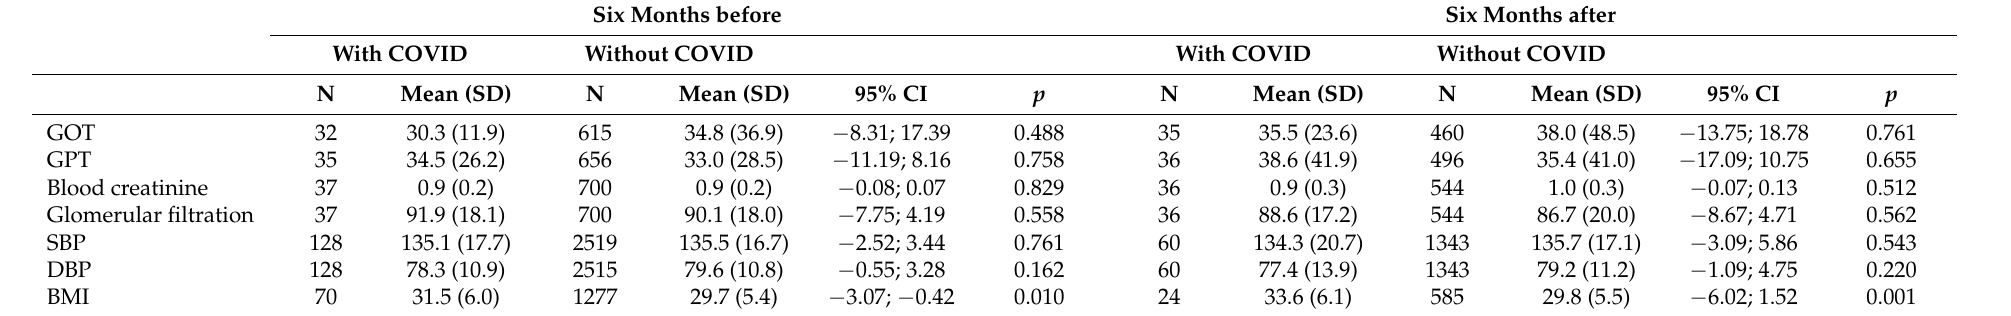
Table 5. Changes in the clinical parameters of patients with alcohol use disorder with COVID-19 and without COVID-19 before lockdown and six months